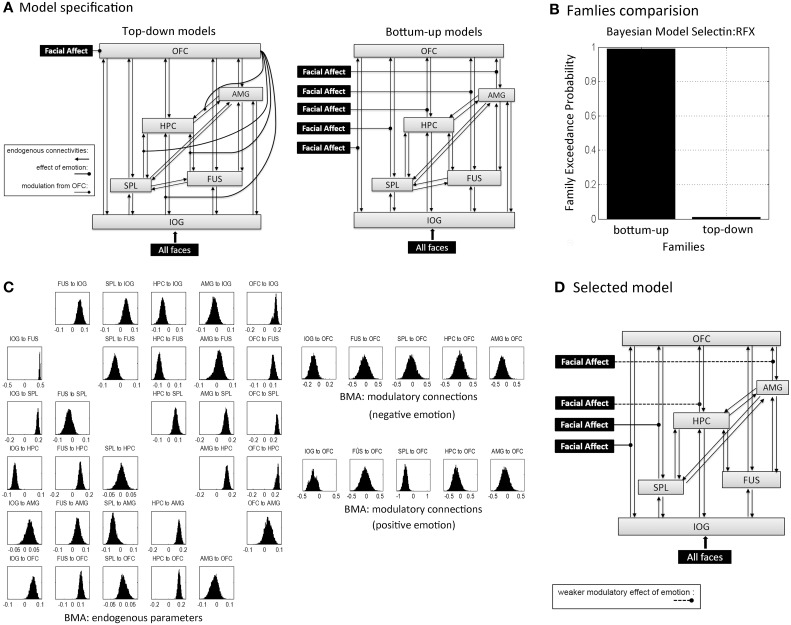
Dynamic Causal Modeling analysis.(A) Concept models for the effective connectivity and emotional modulations within a memory-related network during learning in terms of the top-down and bottom-up approaches. Schematically, inputs of “all faces” are in visual region IOG; the modulations of facial affects correspond to negative and positive facial expressions. Model specification was based on these two concept models with one or several modulatory pathways (see in Supplementary Table B): each one of 27 bottom-up family models had one to five bottom-up pathways that received stimuli from affective faces; all 15 top-down family models processed affective faces in OFC, but each one of top-down models received one to four modulations from OFC. (B) The exceedance probability for family comparison based on random effects analysis from Dynamic Causal Modeling analysis. (C) The posterior densities of average network parameters from random effects Bayesian model averaging for endogenous connections (left) and modulatory connections for negative and positive emotional faces respectively (right). (D) The selected model by DCM analysis (model 25 in Supplementary Table B); the second and fourth best-fitting models implied weaker modulatory effects on the connections from the HPC and AMG to the OFC that are showed in dashed lines.